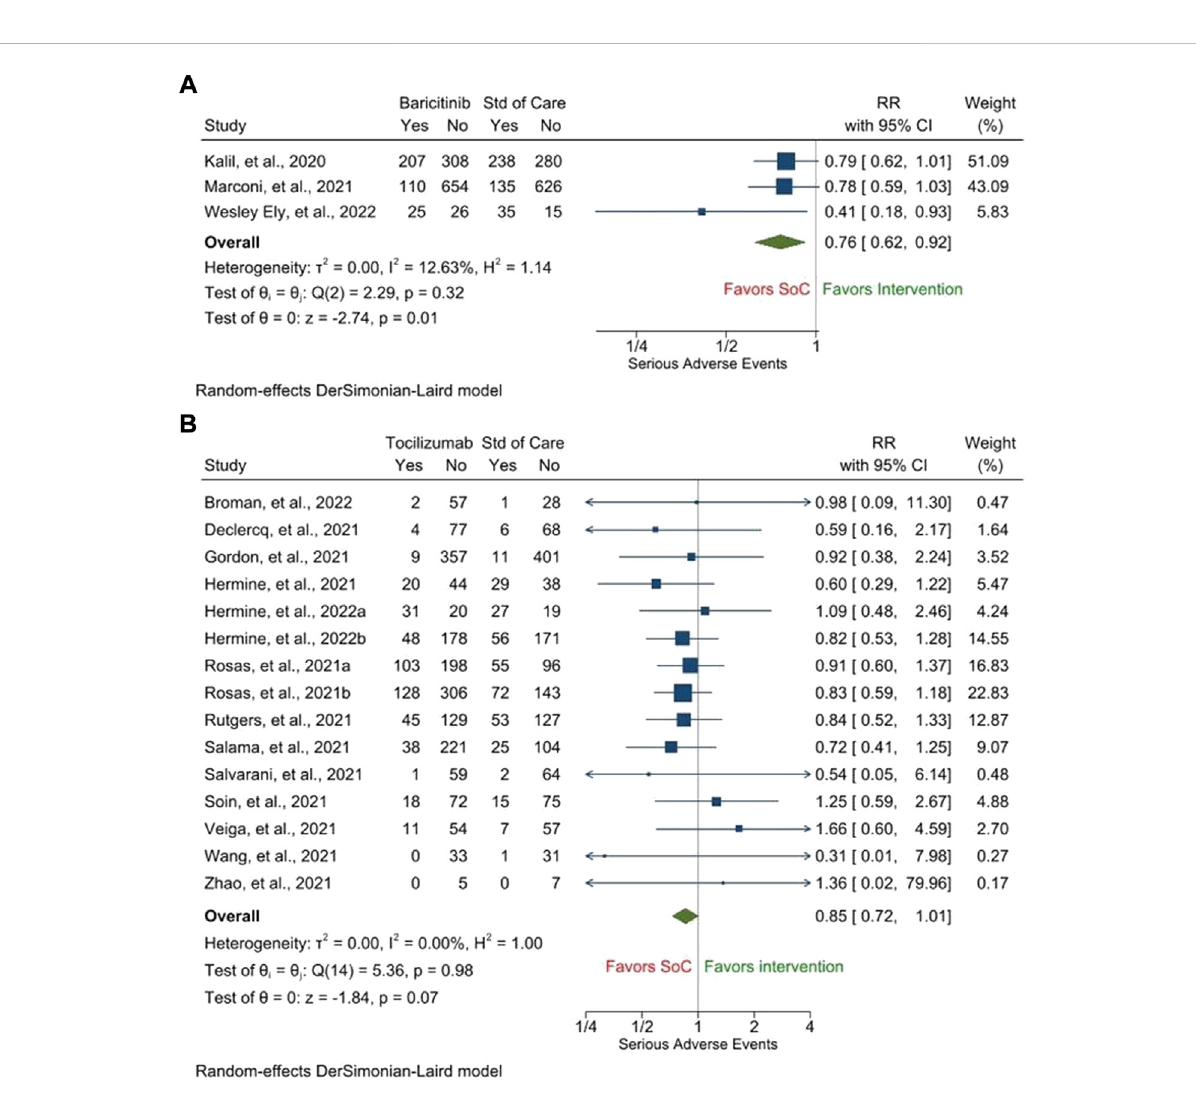
Proportion of patients experiencing any serious adverse events following treatment with baricitinib (A) and tocilizumab (B) as compared to that following treatment with the standard of care